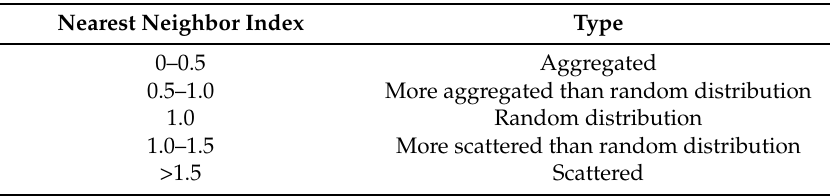
Table 2. k -nearest neighbor index